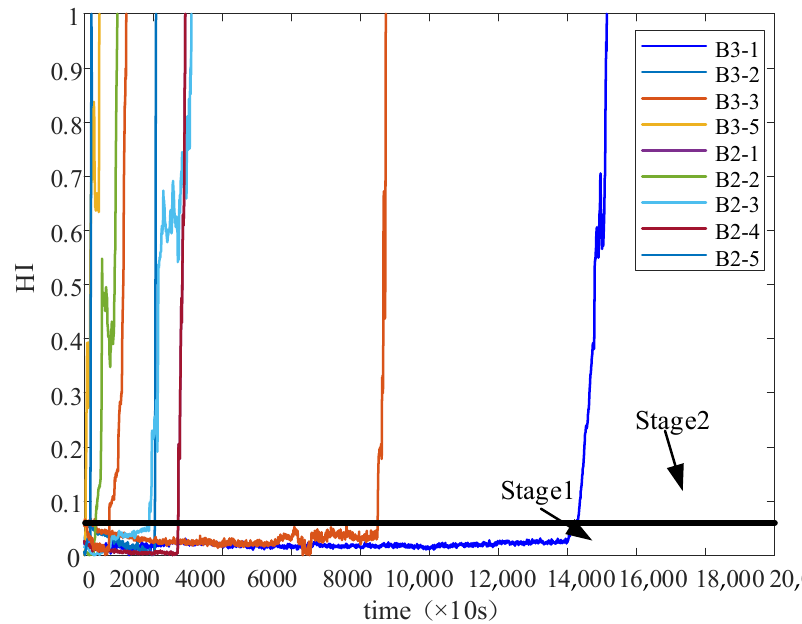
Figure 10. HIs of bearings. Figure 10. HIs of